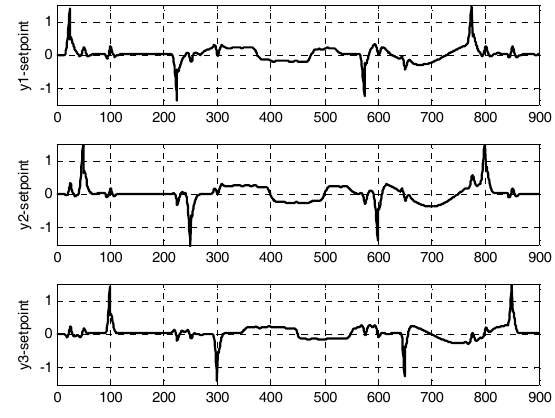
Figure 7. Control error of conventional MPC.